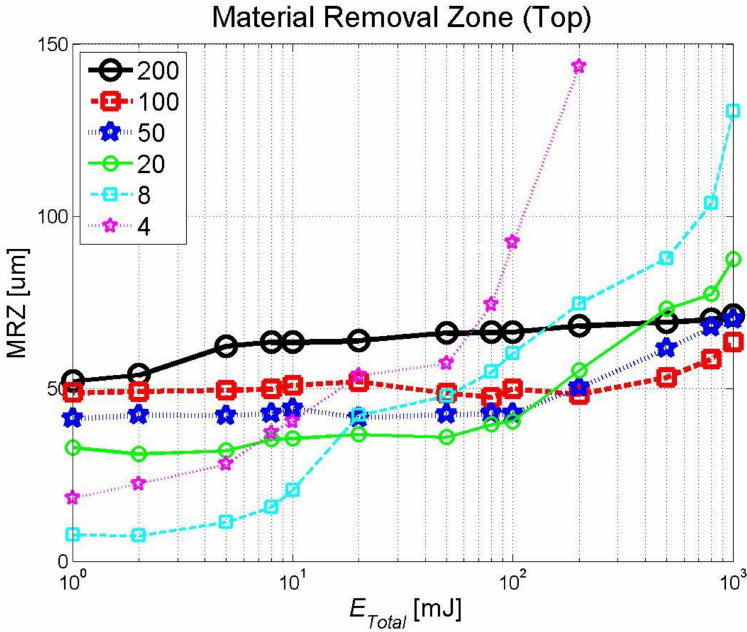
Figure 5. Material removal zone (Top) with the pulse duration from 4 ns to 200 ns The HAZ of the long pulses ( ∆ t = 50, 100, 200 ns) increase steadily with little deviation as E Total increases. On the other hand, the short pulses ( ∆ t = 4, 8, 20 ns) have a large deviation of hole sizes and the sizes rise sharply as E Total